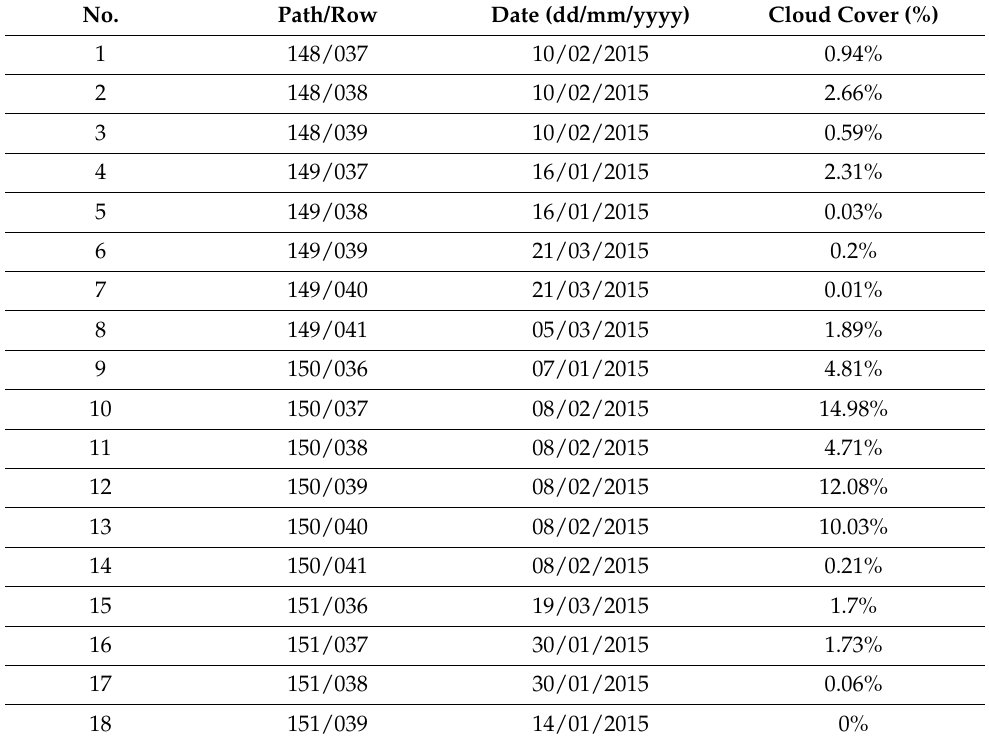
Table 1. List of Landsat 8 scenes used in the